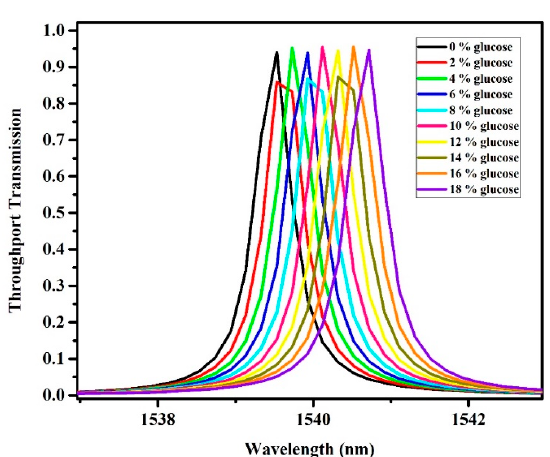
Figure 9. The resonance pulses obtained using the 3D Finite Difference Time Domain (FDTD) method approach showing resonance shifts for each glucose concentration.